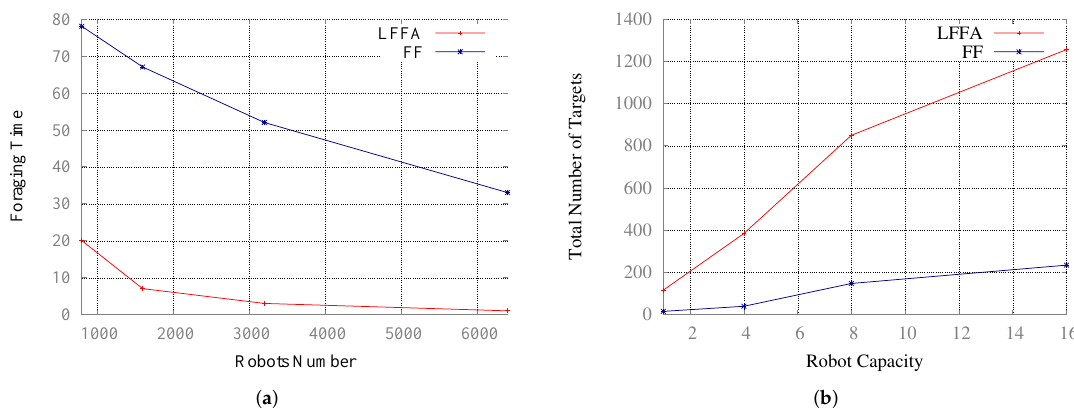
Figure 5. Simulation results: ( a ) foraging time in Scenario 1, ( b ) number of collected food in Scenario